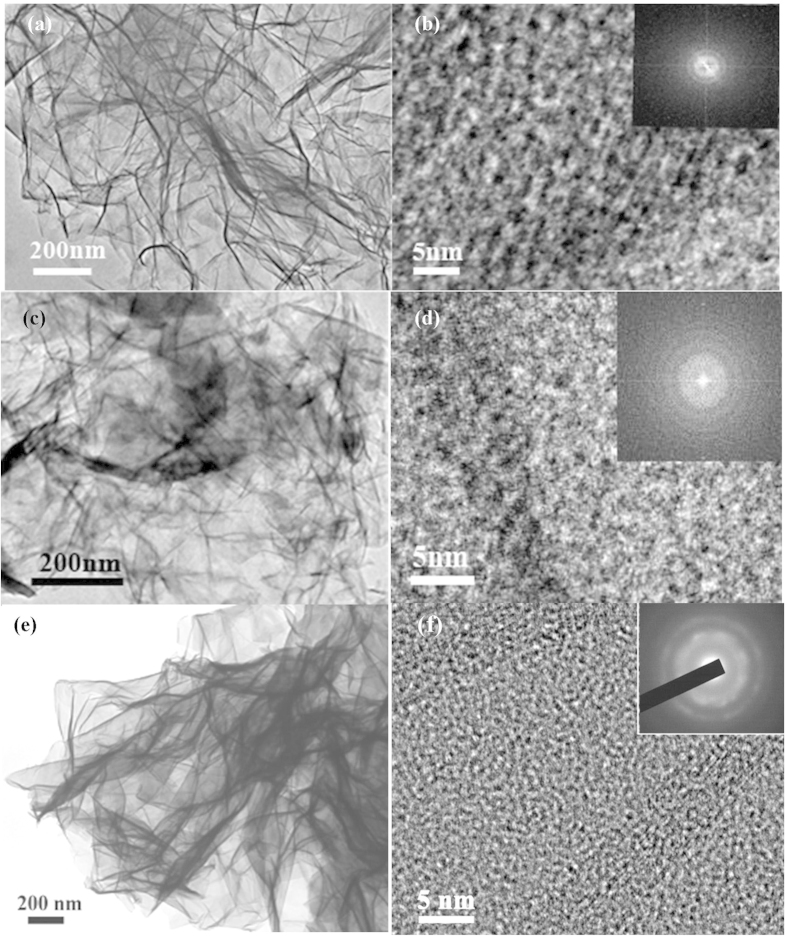
TEM, HRTEM images and SAED patterns of as-prepared samples.α-Ni(OH)2 (a,b), α-Co(OH)2 (c,d), Ni50Co50-LDH(e,f).